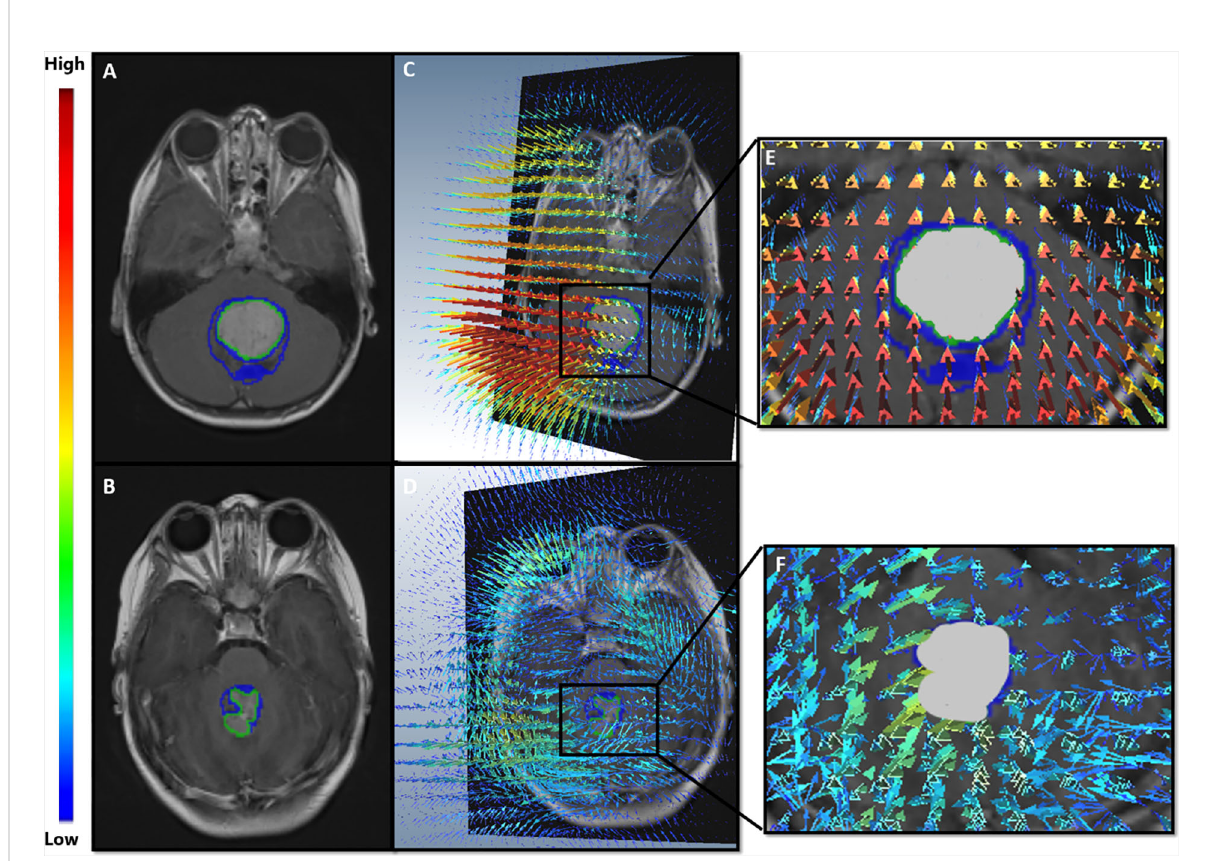
FIGURE 7 (A, B) show Gd-T1w MR scans of the two MB patients; a patient with poor survival (top row), and a patient with prolonged survival (bottom row). (C, D) illustrate the extracted deformation fi eld magnitudes for each of the two patients, respectively. For the patient with poor survival (C) , higher magnitude values (represented in red) were observed in close proximity of the tumor, whereas lower values were observed (blue) for the patient with prolonged survival (D) .